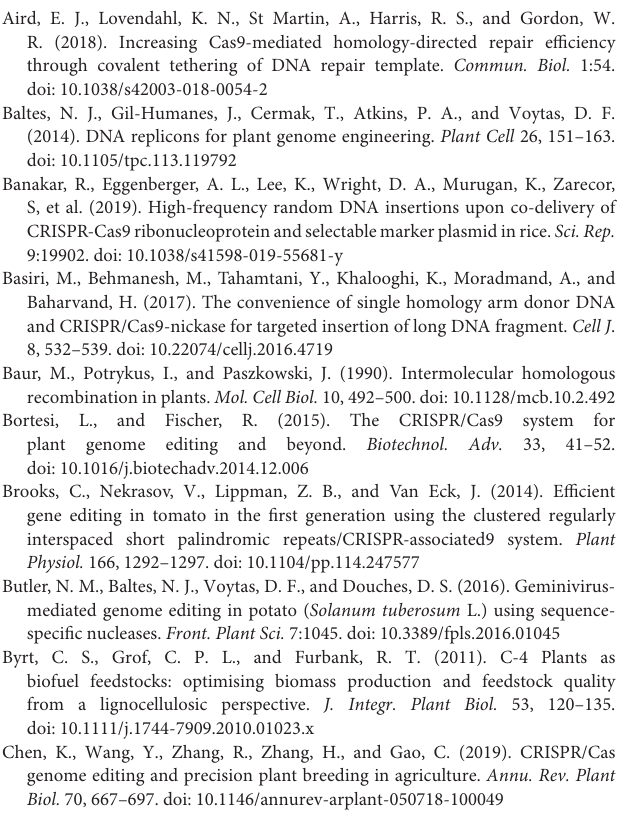
Supplementary Table 5 | GenBank accession IDs for sequence reads of cloned PCR amplicons of the ALS gene with intended mutations W574L and/or S653I from gene-edited